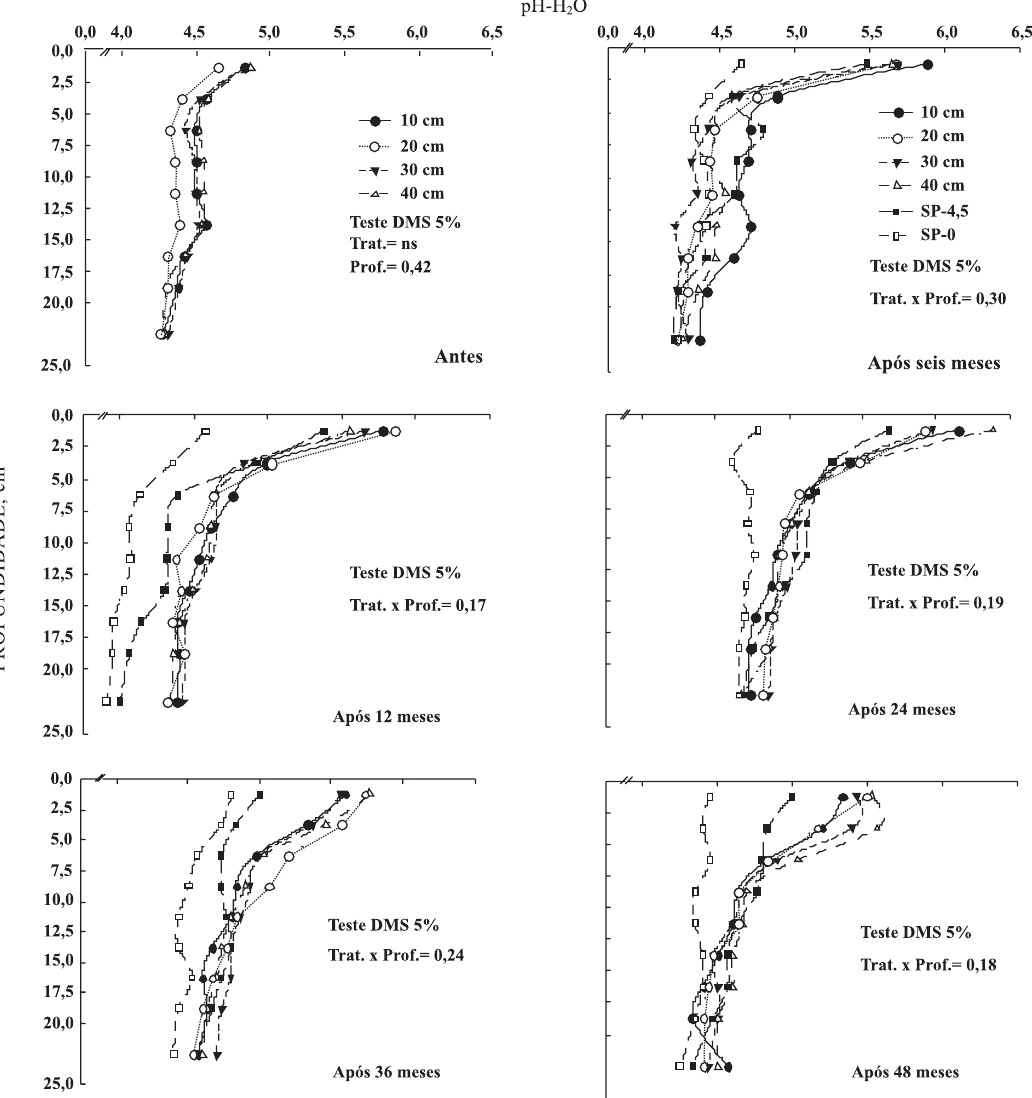
Figura 1. Valores de pH em diferentes épocas da aplicação superficial de calcário em Latossolo Vermelho, sob sistema plantio direto e integração lavoura-pecuária, com diferentes pressões de pastejo no inverno (ns: não